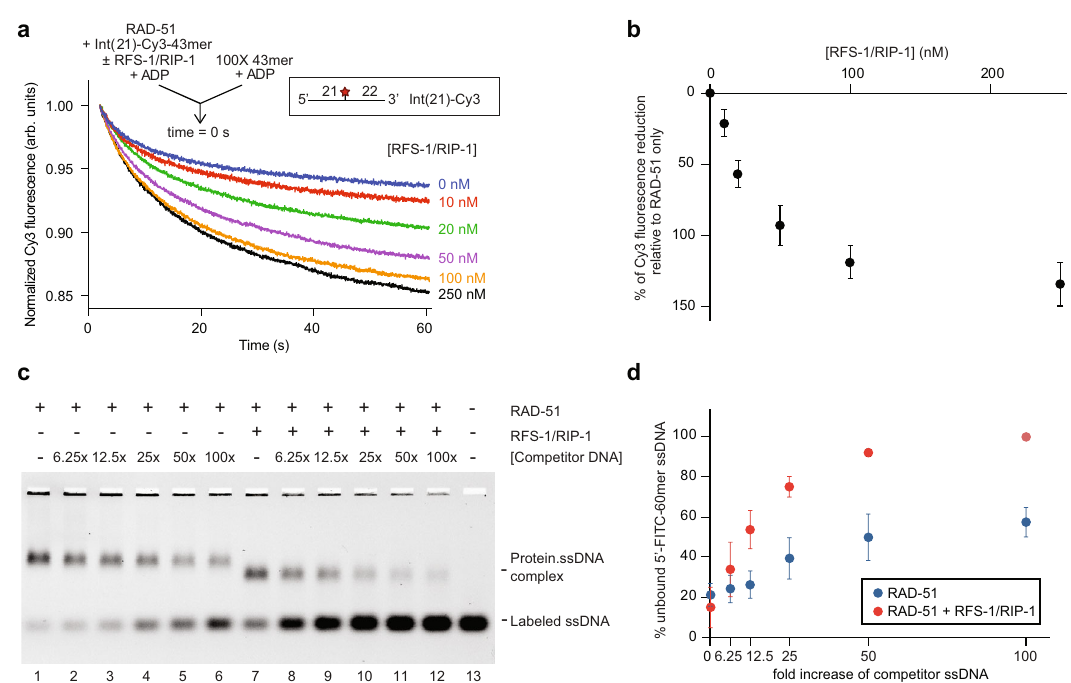
Fig. 3 RFS-1/RIP-1 destabilizes RAD-51-ssDNA fi laments in the presence of ADP. a Average normalized Cy3-43mer fl uorescence pro fi les plotted as a function of time. The arrow indicates the components of the two syringes rapidly mixed at the 0 s time point in a stopped fl ow instrument. RAD-51-ssDNA fi laments pre-formed with RAD-51 (1 μ M) and Int(21)-Cy3 labelled 43mer ssDNA (15 nM) and indicated concentrations of RFS-1/RIP-1 were mixed for 10 min in the presence of ADP. The mixture was then challenged with 100-fold excess of unlabelled 43mer and analyzed ( n = 5 – 8). b Graph of RFS-1/RIP-1 concentration-dependence change of Cy3 fl uorescence from ( a ) (mean; errors: s.d.). c Representative EMSA gel ( n = 4) demonstrating destabilization of RAD-51-ssDNA fi laments in the presence of ADP. RAD-51 (1 μ M) and RFS-1/RIP-1 (0.5 μ M) were pre-incubated before addition of 5 ′ -FITC-61mer ssDNA (10 nM) for 10 min and then challenged with increasing amounts of unlabelled 61mer ssDNA for a further 10 min. Protein-DNA complexes were crosslinked and resolved in agarose gels. d The amount of unbound 5 ′ -FITC-61mer ssDNA from ( c ) ( n = 4) was quanti fi ed. The average percentage of unbound 5 ′ - FITC-61mer ssDNA was plotted as a function of the relative excess concentration of unlabelled 61mer over 5 ′ -FITC-61mer ssDNA (mean; errors: s.d.). Source data are provided as a Source Data fi